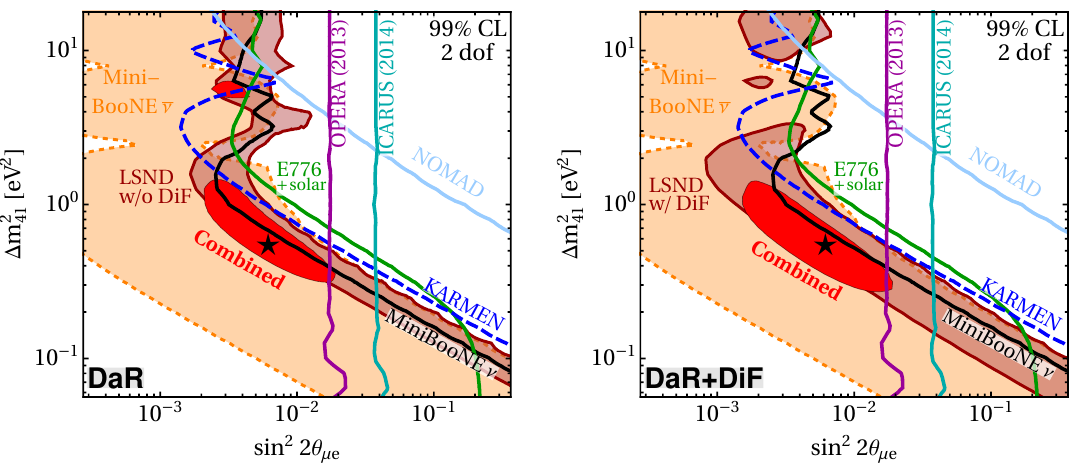
Figure 4 . Constraints on short-baseline (cid:23) (cid:22) ! (cid:23) e and (cid:22) (cid:23) (cid:22) ! (cid:22) (cid:23) e oscillations in the presence of sterile neutrinos in 3 + 1 scenarios. We show the allowed parameter regions, projected onto the plane spanned by the e(cid:11)ective mixing angle sin 2 2 (cid:18) (cid:22)e (cid:17) 4 j U e 4 j 2 j U (cid:22) 4 j 2 and the mass squared di(cid:11)erence (cid:1) m 2 . In the left panel only decay-at-rest (DaR) data from LSND is included, while in the right 41 panel also decay-in-(cid:13)ight data (DiF) is